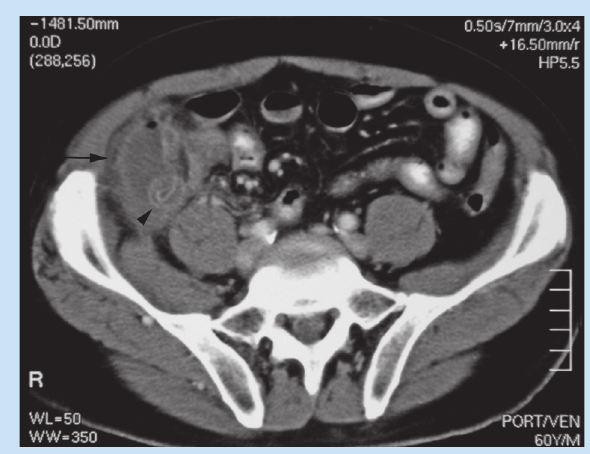
Fig. 5. CT scan of the abdomen. A fluid collection containing a gas locule (arrow) is seen adjacent to the thick-walled distended appendix (arrow- head). Fig. 5 is inferior to Fig.